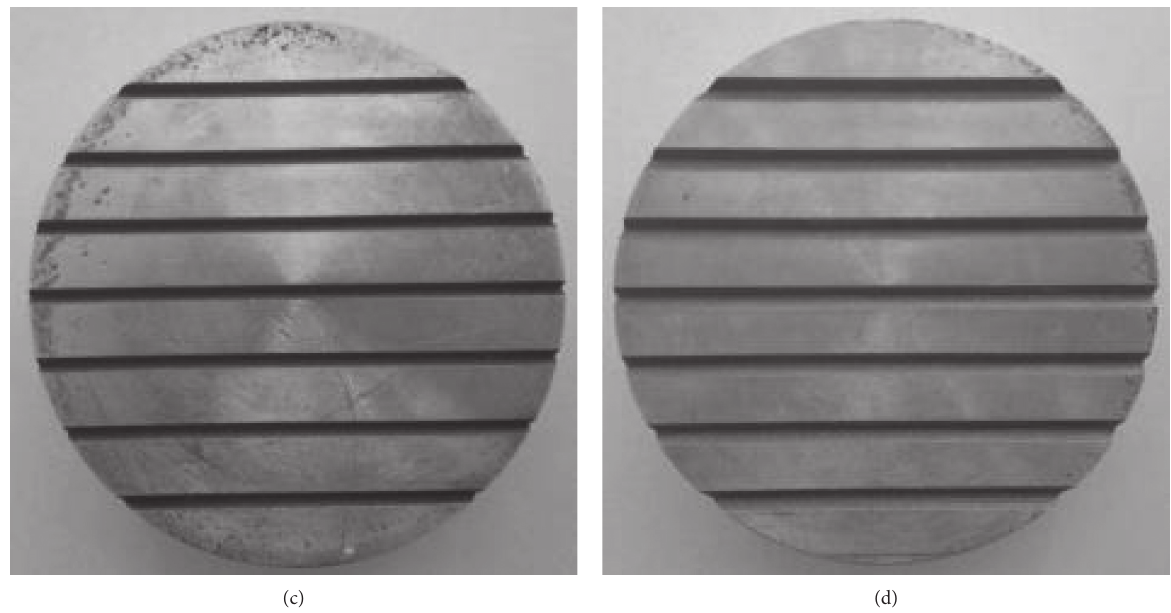
Figure 5: Front view of the steel plate used in the test. (a) Int-A; (b) Int-B; (c) Int-C; (d) Int-D.